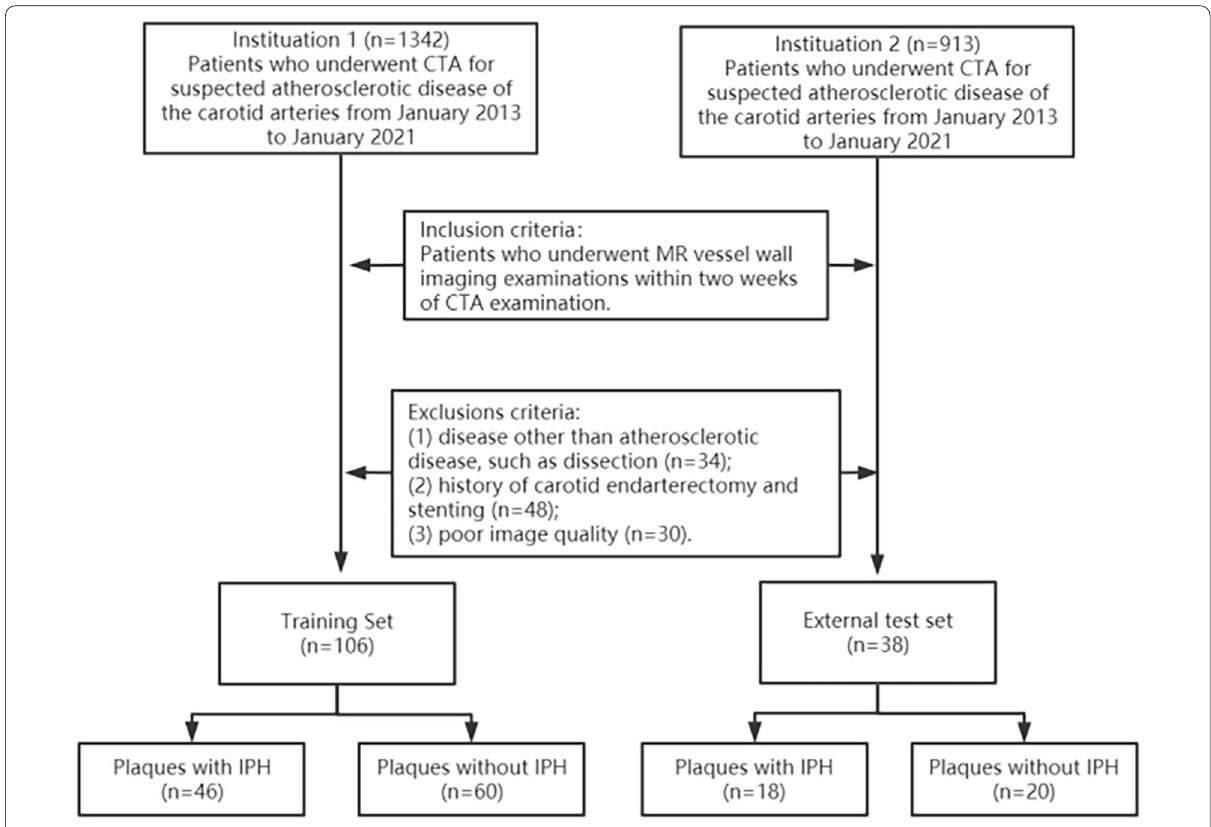
Fig. 1 Flow diagram of the study. IPH